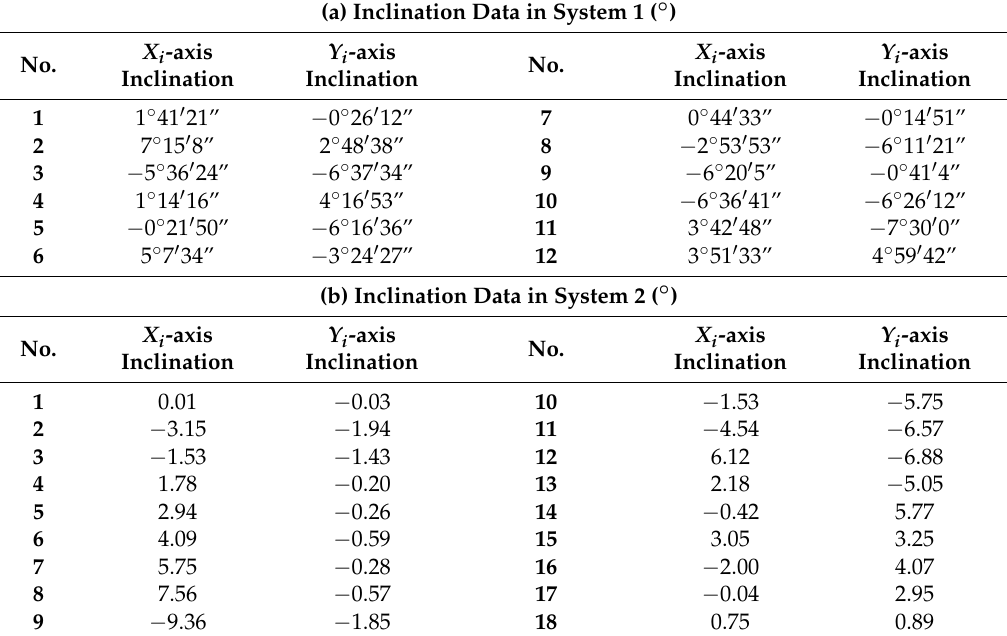
Table 3. The measured inclination